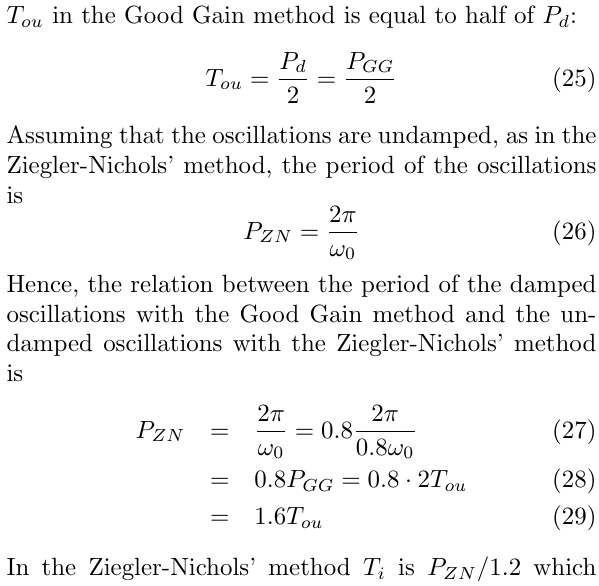
Figure 13: Responses in the level control system with Ziegler-Nichols tuning.